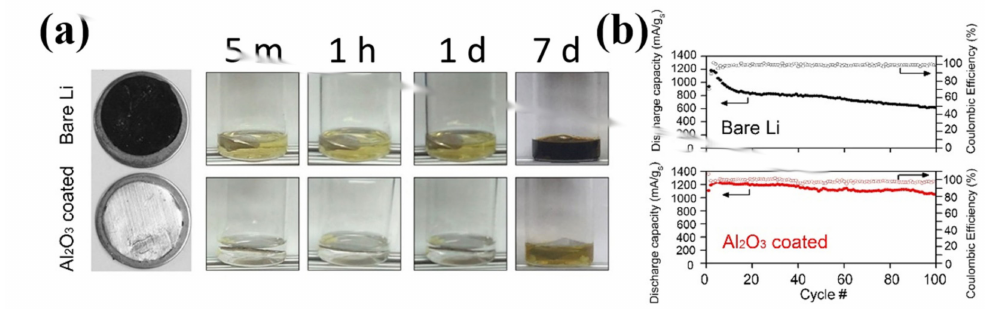
Figure 1. ( a ) Optical images of coated and uncoated Li metal after atmospheric exposure at 25 ◦ C and 40% RH, and exposure to 1 M sulfur/DME solution ( b ) Discharge capacity normalized to sulfur mass and Coulombic efficiency of Li-S full cells using bare Li metal anode and 14 nm ALD Al 2 O 3 protected anode [30]. Reproduced with permission [30]. Copyright 2015, American Chemical